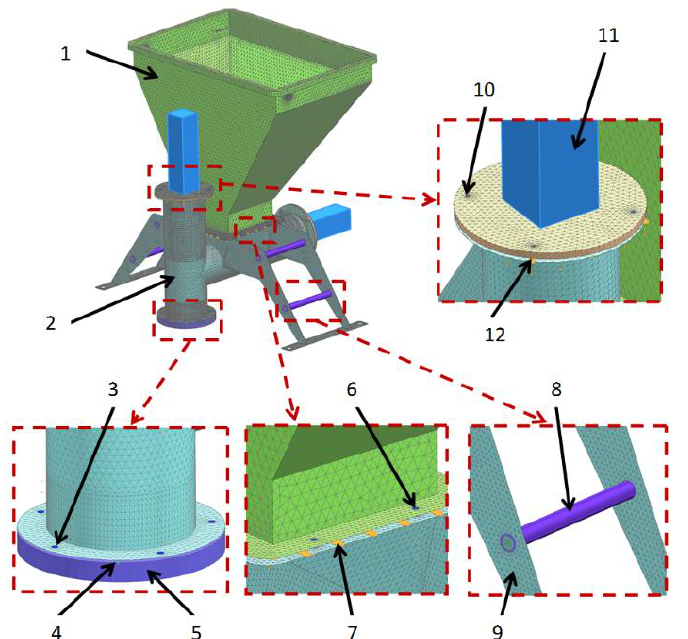
Figure 4. Calculation model of molding center with a processing tank. View 1: actuator, bolted connection, contact set, axis, and element (el.). 1. Technological tank (2D elements), 2. Vertical dispenser (2D elements), 3. Screw connection (1D elements), 4. Contact set, 5. Sliding unit (3D elements). 6. Screw connection (1D elements), 7. Contact set, 8. Connector (1D elements), 9. Forming center support brackets (2D elements), 10. Screw connection (1D elements), 11. Pneumatic actuator (1D elements), 12. Contact